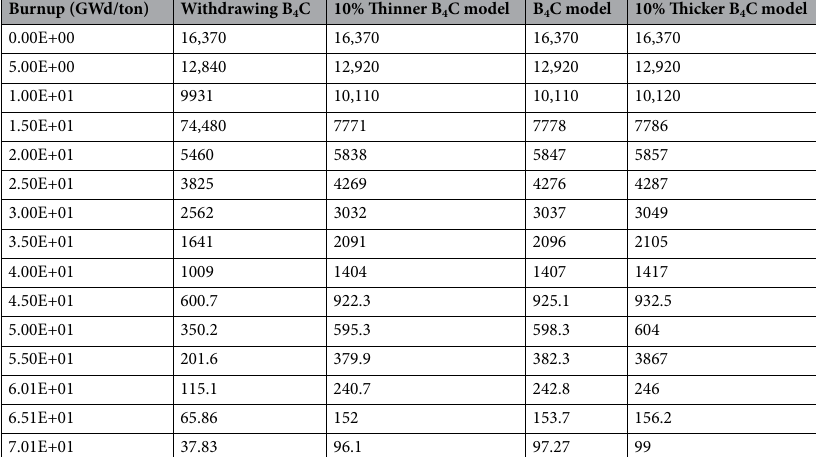
Table 4. Mass of U-235 at the different stages of burnup for the 4 cases.